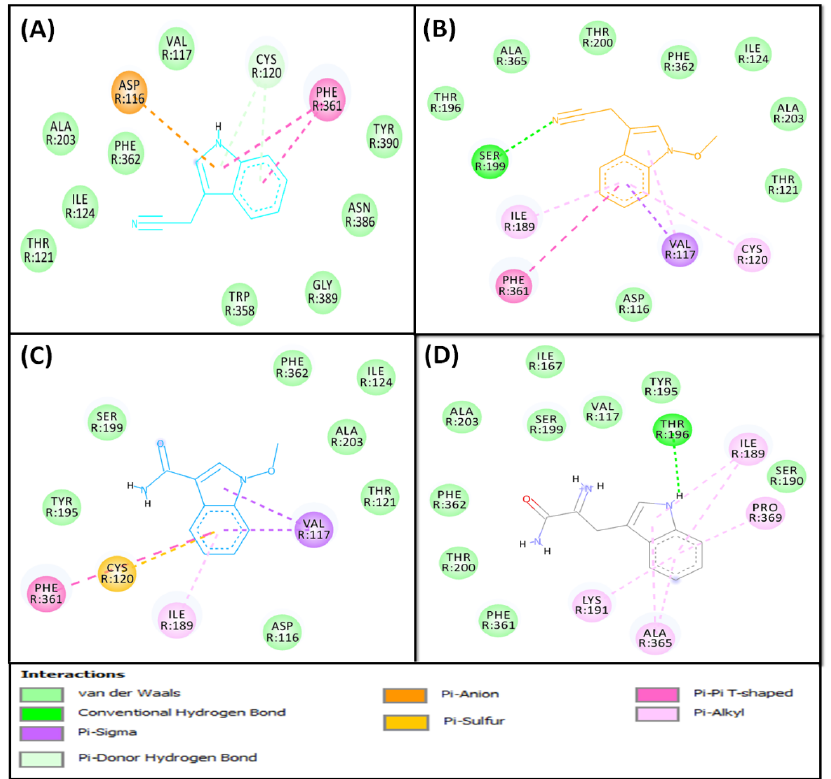
Figure 6. Molecular interaction between SI indole compounds and 5-HT 1A . ( A ) Compound 5 , ( B ) compound 6 , ( C ) compound 7 , and ( D ) compound 8